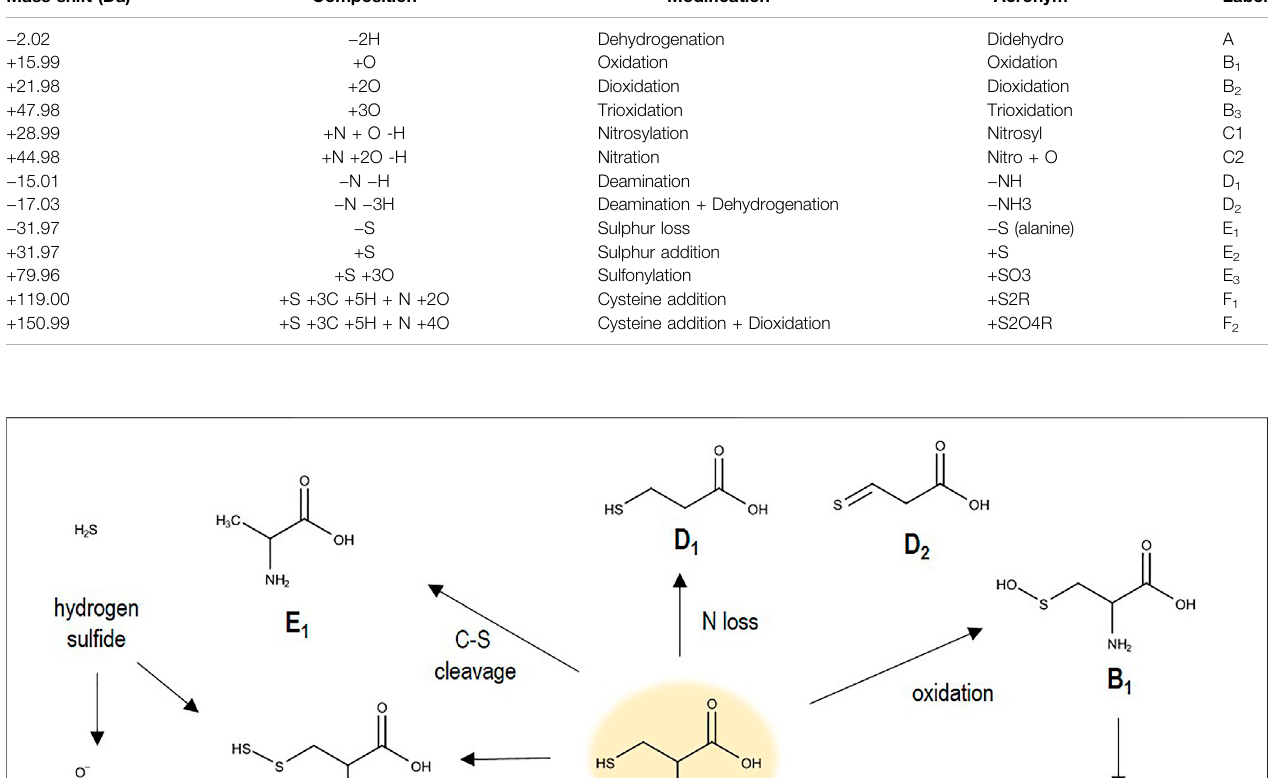
Frontiers in Physics |